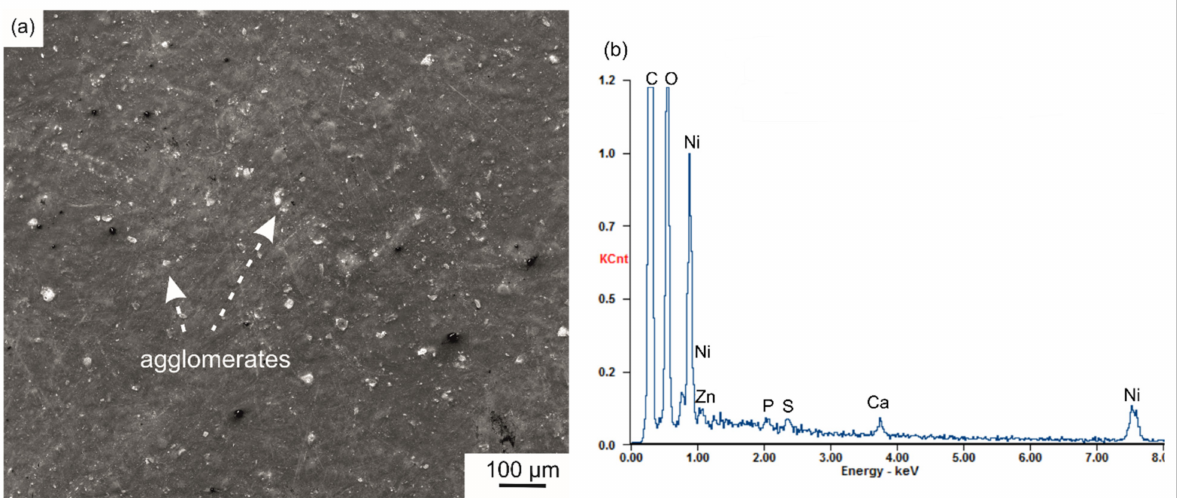
Figure 10. Surface morphology ( a ) and SEM-EDS spectrum ( b ) of the n-HA/ZnS/S-PEEK coating, SEM. Ni in the spectrum was generated from the sputtered conductive